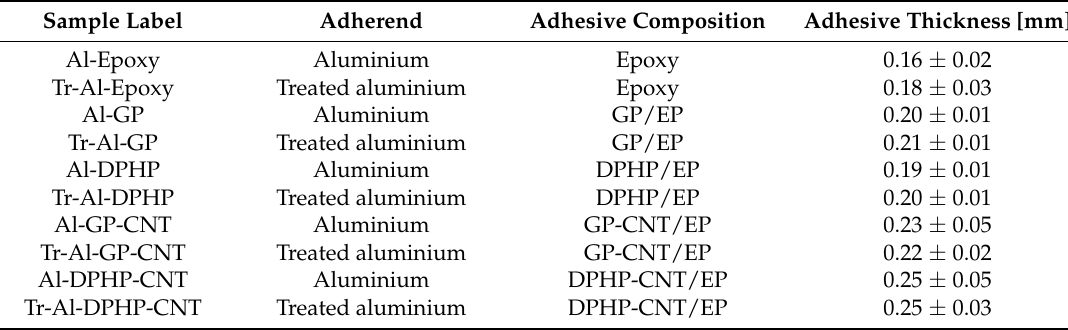
Table 3. Summary of the prepared single lap joint